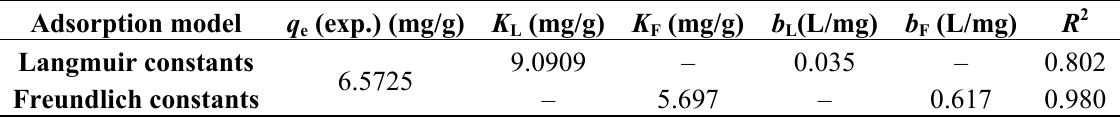
Table 1. Langmuir and Freundlich isotherm for sorption of